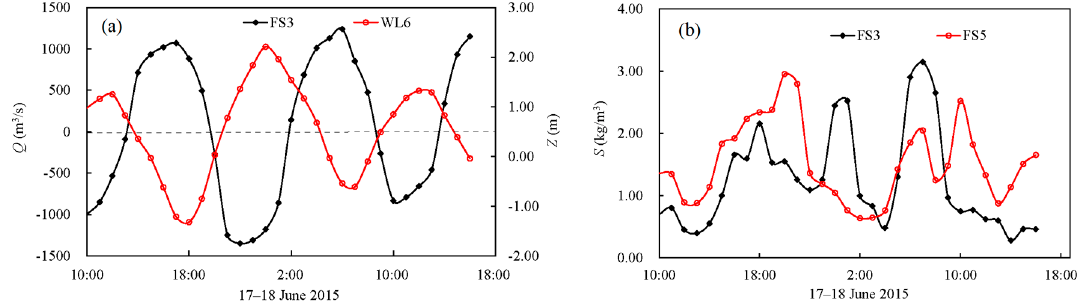
Figure 8. Measured Q, Z and S as boundary conditions: ( a ) Q~t and Z~t; ( b ) S~t.